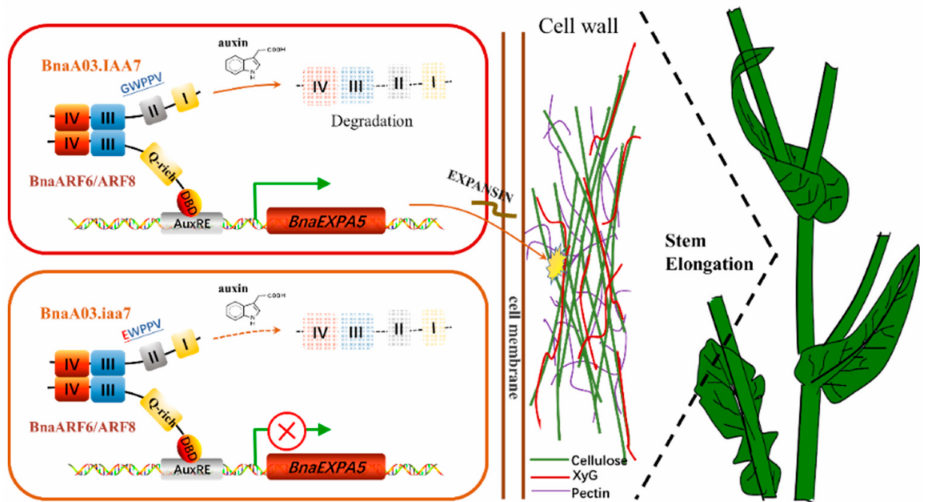
Figure 7. Model of stem elongation controlled by BnaEXPA5 in Brassica napus . Under the appropriate concentration, auxin mediates the ubiquitination and degradation of BnaA03.IAA7 releasing its inhibition on BnaARF6 and BnaARF8. Then the transcription of BnaEXPA5 is activated, and its protein products play the role of loosening the wall and promoting the process of plant stem elongation. In ndf-2 , the mutated EWPPV motif of BnaA03.iaa7 prevents its degradation, and the inhibition on BnaARF6 and BnaARF8 continues, so the transcription of BnaEXPA5 is